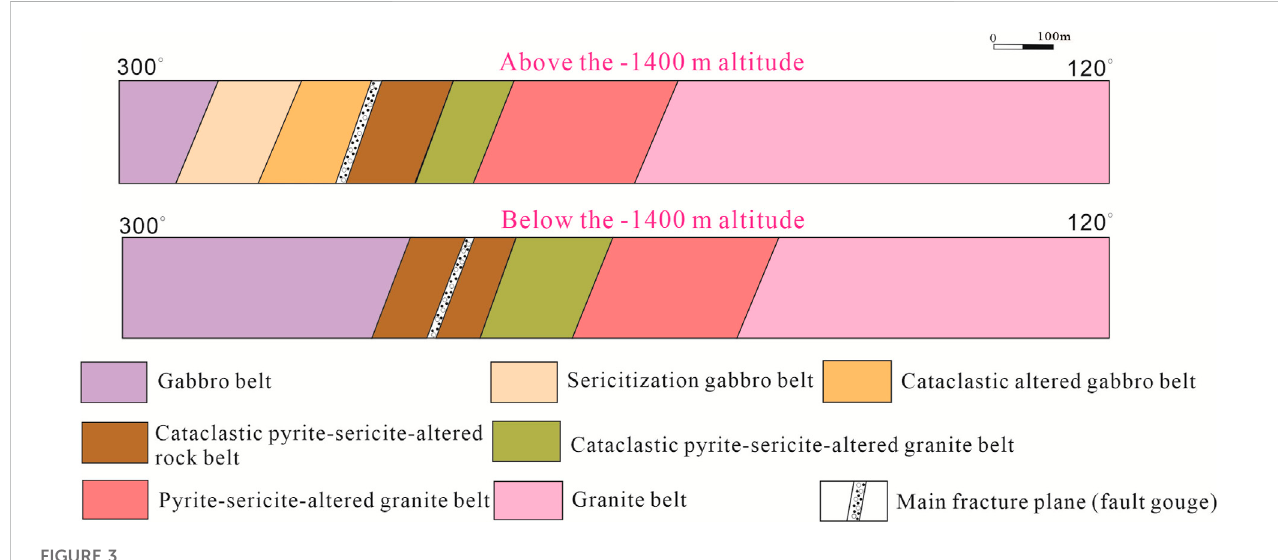
FIGURE 3 Schematic alteration zoning pro fi le in the Zhaoxian gold deposit.